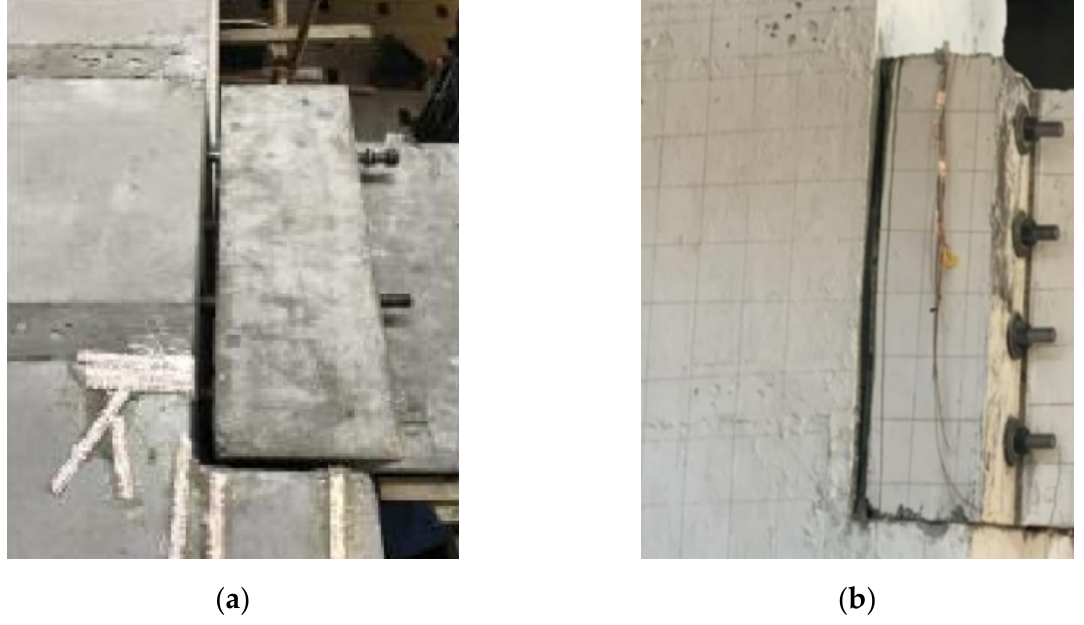
Figure 3. Precast beam–column connection joints. ( a ) Splice in precast beams and columns; ( b ) splice in precast beams and columns after grouting.